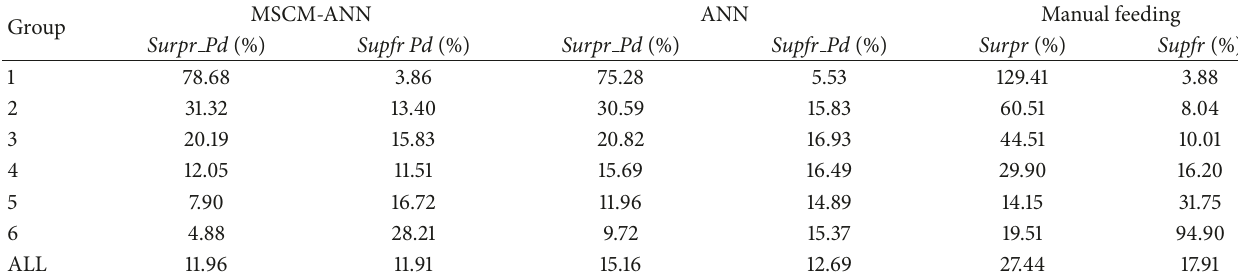
Table 8: Comparison of surplus rate and supplemental feeding rate.